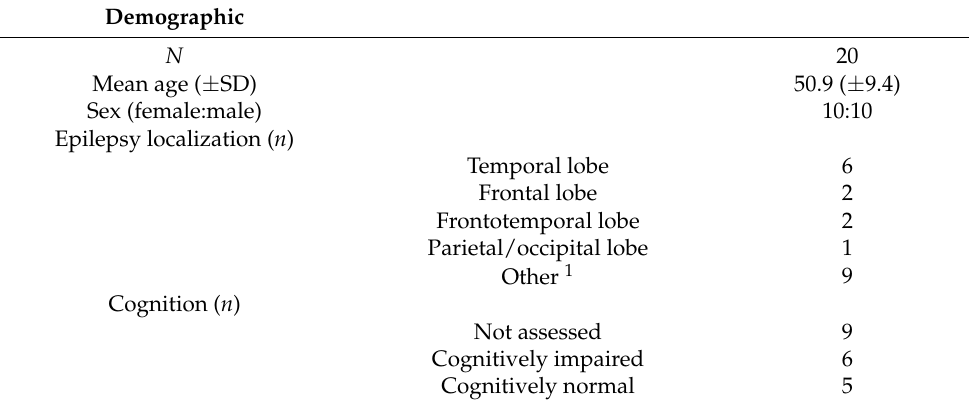
Table 1. Demographic data, including mean age in years ( ± SD), sex, epilepsy localization, and cognitive status, as available.